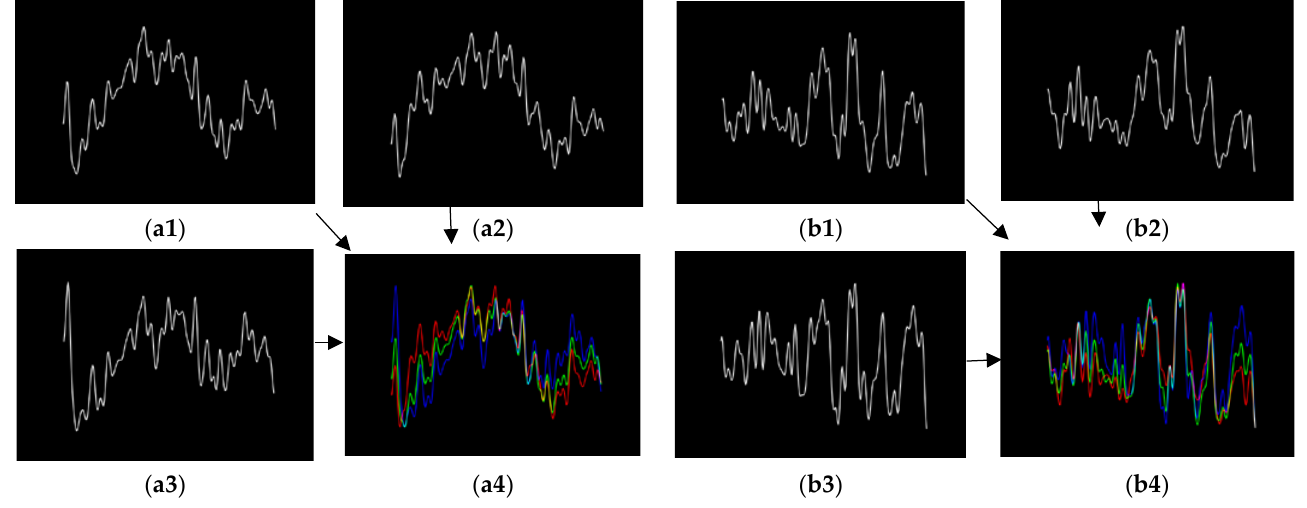
Figure 5. Combination of Fp1, Fpz, and Fp2 into RGB images (the background color is set to black in order to better show the color change in the RGB synthesis. Additionally, these graphs have no axes). ( a1 – a4 ) The three channels of data for depression sample (subject ID: 02010005) are plotted separately; ( a1 ) Fpz; ( a2 ) Fp1; ( a3 ) Fp2; ( a4 ) RGB synthesis; ( b1 – b4 ) and data synthesis by RGB for three channels of health sample (subject ID: